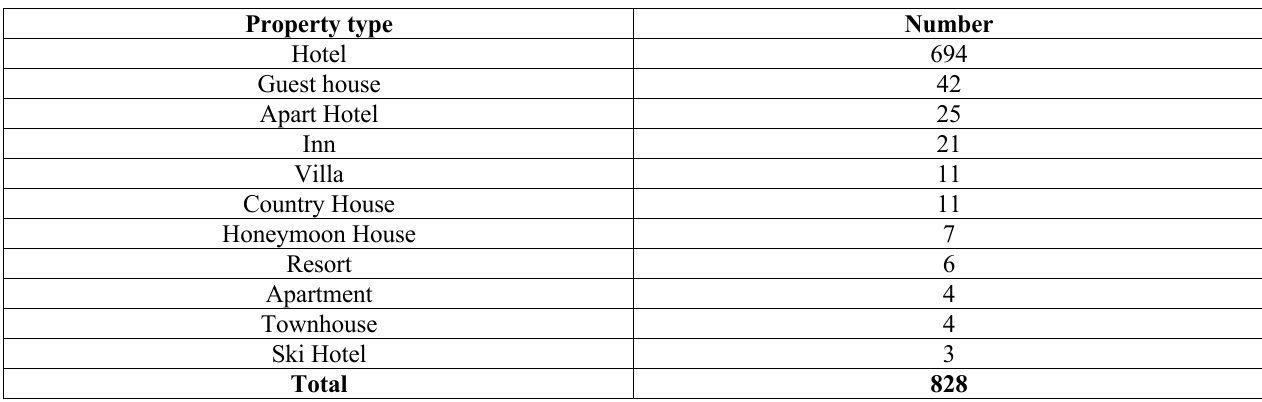
Table 5. Distribution of halal concept accommodation businesses according to their type Source: Authors’ elaboration